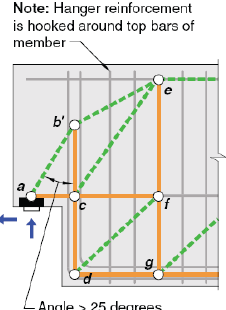
Figure 24: Adjusted strut-tie-model to satisfy 23.2.7